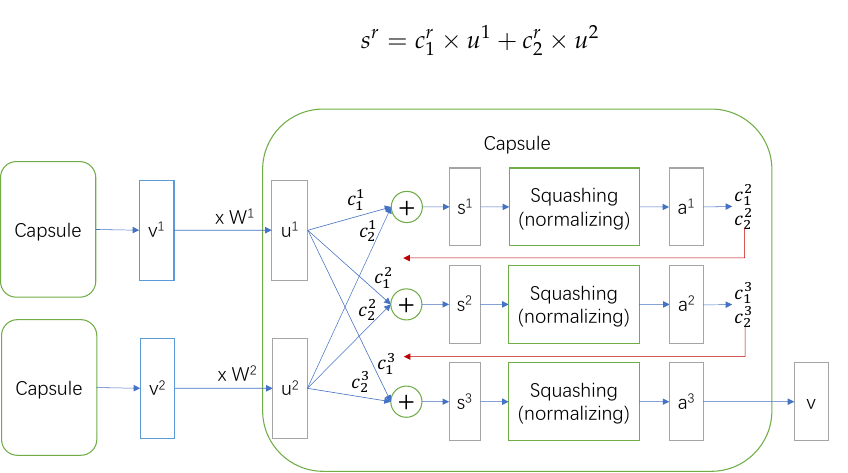
Figure 6. Dynamic routing